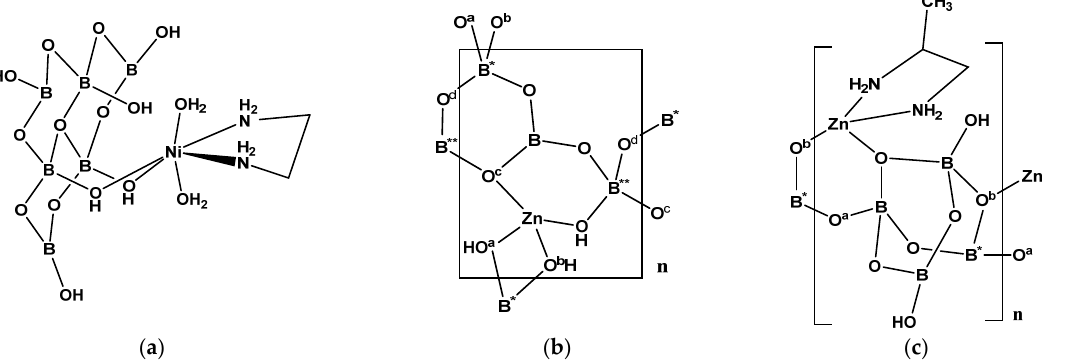
Figure 8. ( a ) The uncharged complex of [Ni(en)(H 2 O) 2 {B 6 O 7 (OH) 6 }] . H 2 O ( 31 ) showing the bidentate nature of the [B 6 O 7 (OH) 6 ] 2- ligand, ( b ) the building unit of [Zn{B 3 O 4 (OH) 3 }] n ( 35 ), and ( c ) the building unit of [Zn(pn){B 4 O 6 (OH) 2 }] n ( 36 ).